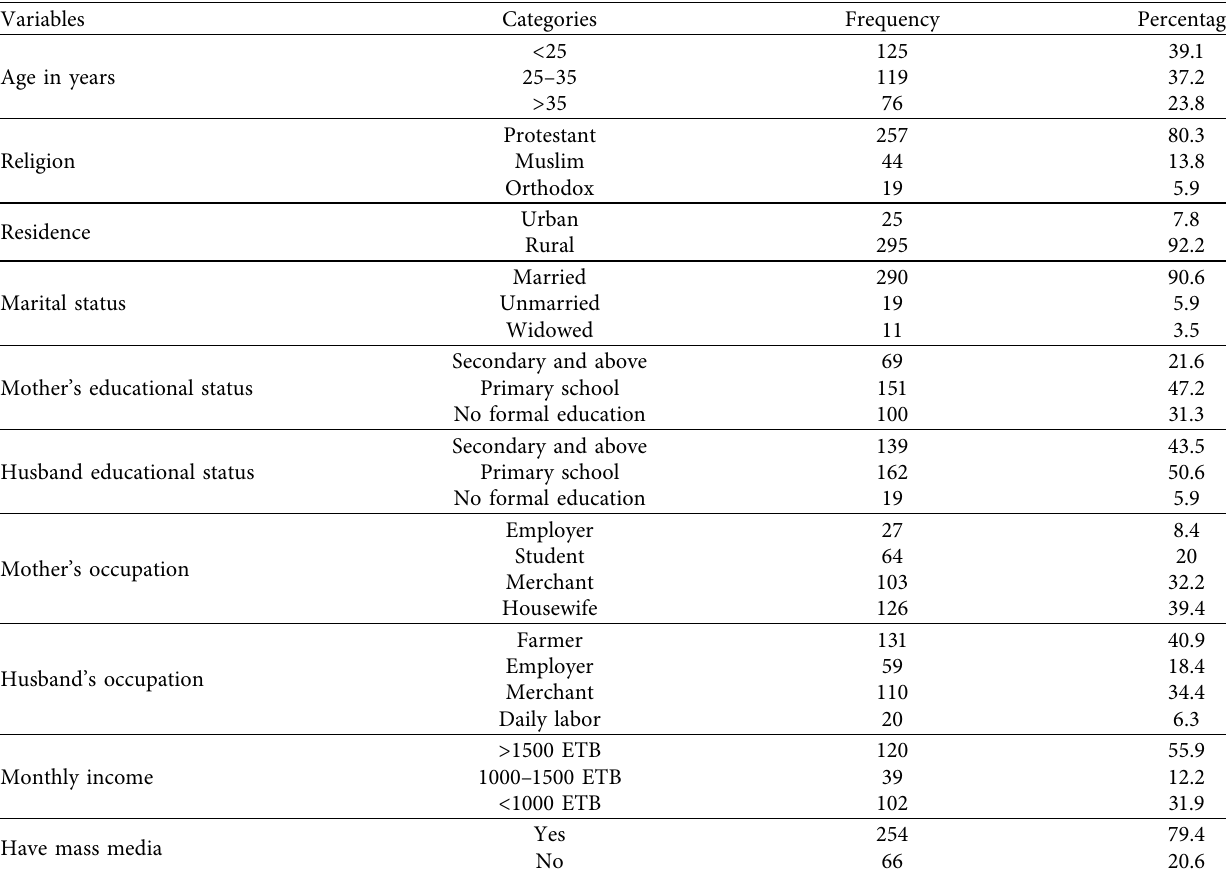
Table 1: Sociodemographic characteristics of the study participants in Hawassa Zuria district, Sidama Regional State, Ethiopia, 2020. Variables